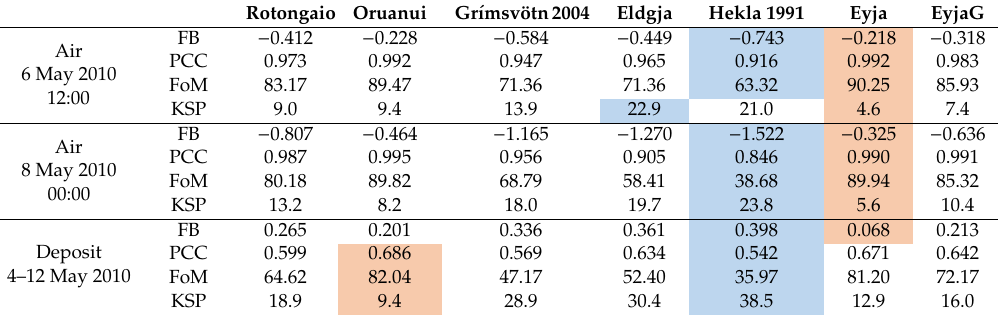
Table 5. Statistical di ff erences between VAAC default PSD and all other PSD results. FB = fractional bias; PCC = Pearson’s Correlation Coe ffi cient; FoM = Figure of Merit in Space; KSP = Kolmogorov–Smirnov Parameter. Pink indicates closest to VAAC default, and blue is furthest